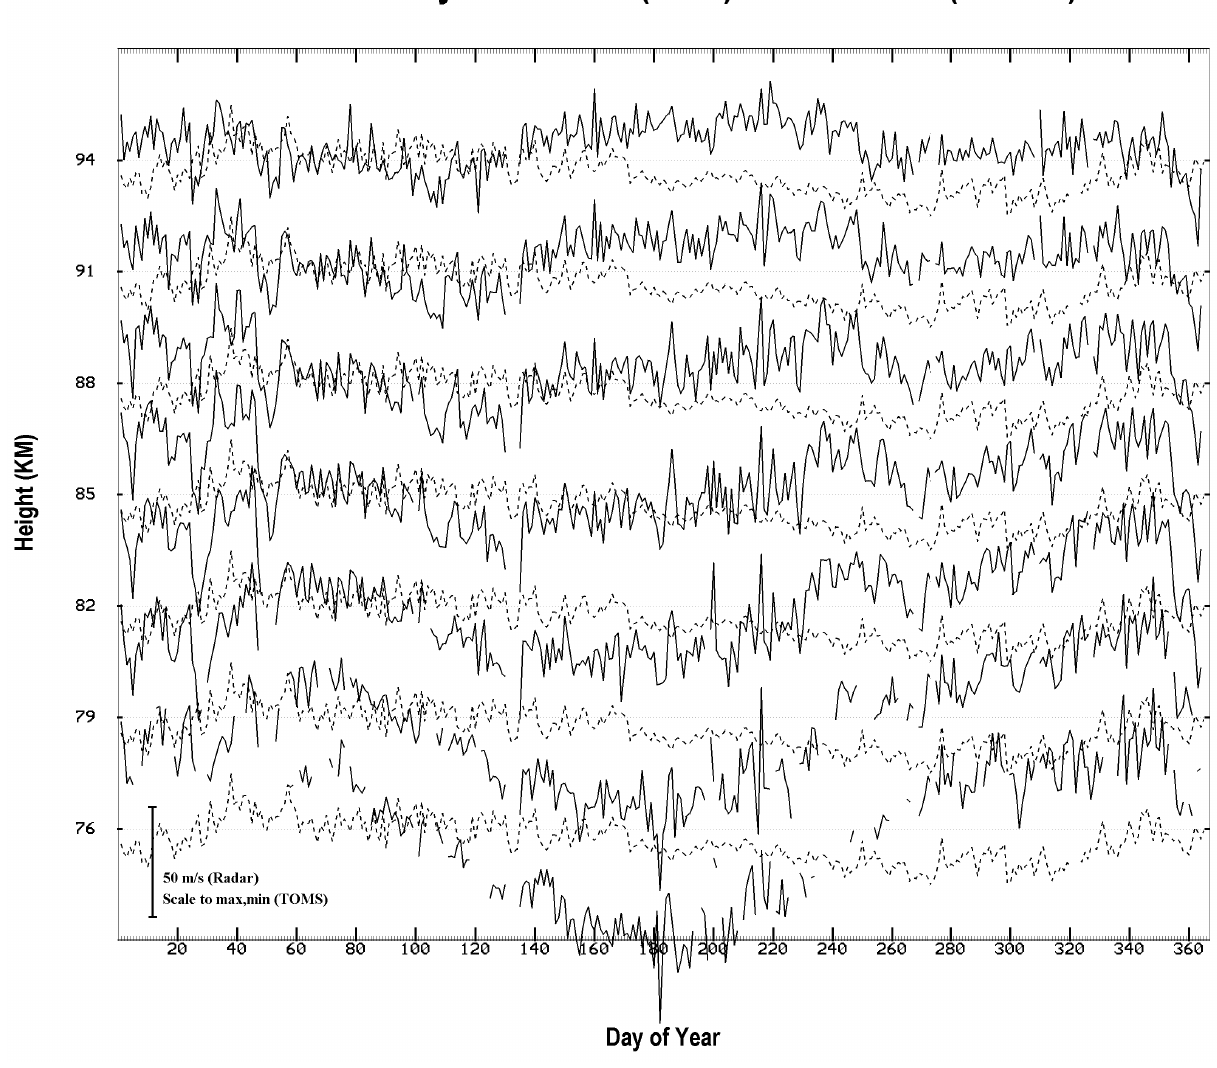
Fig. 1. Time sequences of daily mean zonal (east-west, EW) winds from the MF radar at Saskatoon (52 ◦ N) for heights from 76- 94km: the distance between the 3km samples represents 50m/s. The dashed lines are for TOMS values (median DU value in a 5*5 grid point cell centred on Saskatoon): these are arbitrarily scaled according to the maximum variation during the year. The TOMS sequences are repeated at each MFR